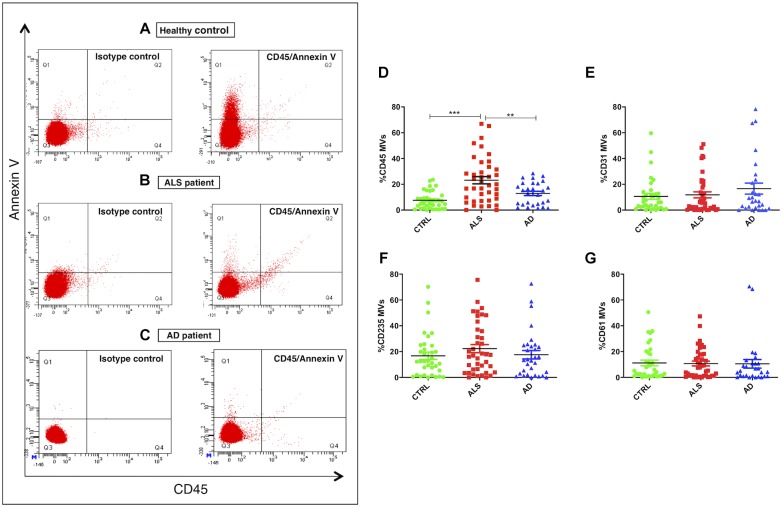
LMVs overrepresentation in plasma from ALS patients. Flow cytometry dot plots of MVs isolated from plasma of a representative healthy control, an ALS patient and AD patient labeled with Annexin V and CD45 (A–C). While healthy control (A) and AD patient (C) presented few events similar to isotype control, ALS patient (B) had higher % CD45+/Annexin V+ MVs. Dot plots of MVs isolated from plasma of ALS patients (red), healthy controls (green), and AD patients (blue) labeled with Annexin V and CD45 (D), CD31 (E), CD235A (F), CD61 (G) markers. Results were referred as the percentage of Annexin V+ MVs expressing the cell lineage marker. While Annexin V+ MVs derived from endothelium (%CD31 MVs) (E), erythrocytes (%CD235a MVs) (F), platelets (%CD61 MVs) (G) were not different from the healthy control subjects and AD patients (ANOVA test, p > 0.05), the percentage of Annexin V+ MVs derived from leukocytes (%CD45 MVs) (D) was significantly enhanced in the plasma of ALS patients compared to the control group (ANOVA test, ∗∗∗p < 0.001) and the AD patients (ANOVA test, ∗∗p < 0.01). n CTRL = 36; n ALS = 40; n AD = 28.